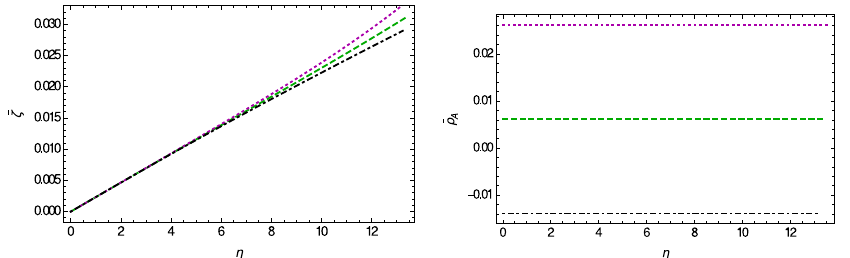
Fig. 2 Variation of the non-zero component ¯ ζ (left panel) and of the effective energy density ¯ ρ A (right figure) of the three-form field as a function of the radial distance from the center of the stiff-fluid star η withconstantpotential,forthreedifferentvaluesoftheconstant ¯ λ : ¯ λ = 0